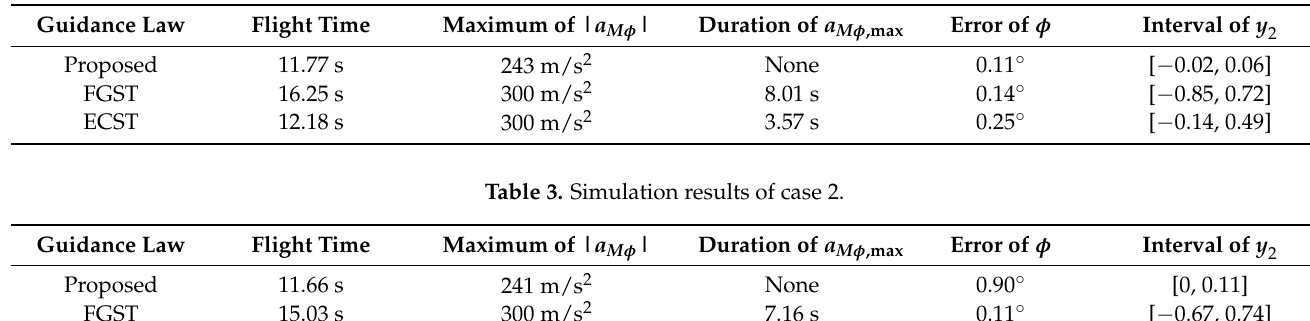
Table 2. Simulation results of case 1.